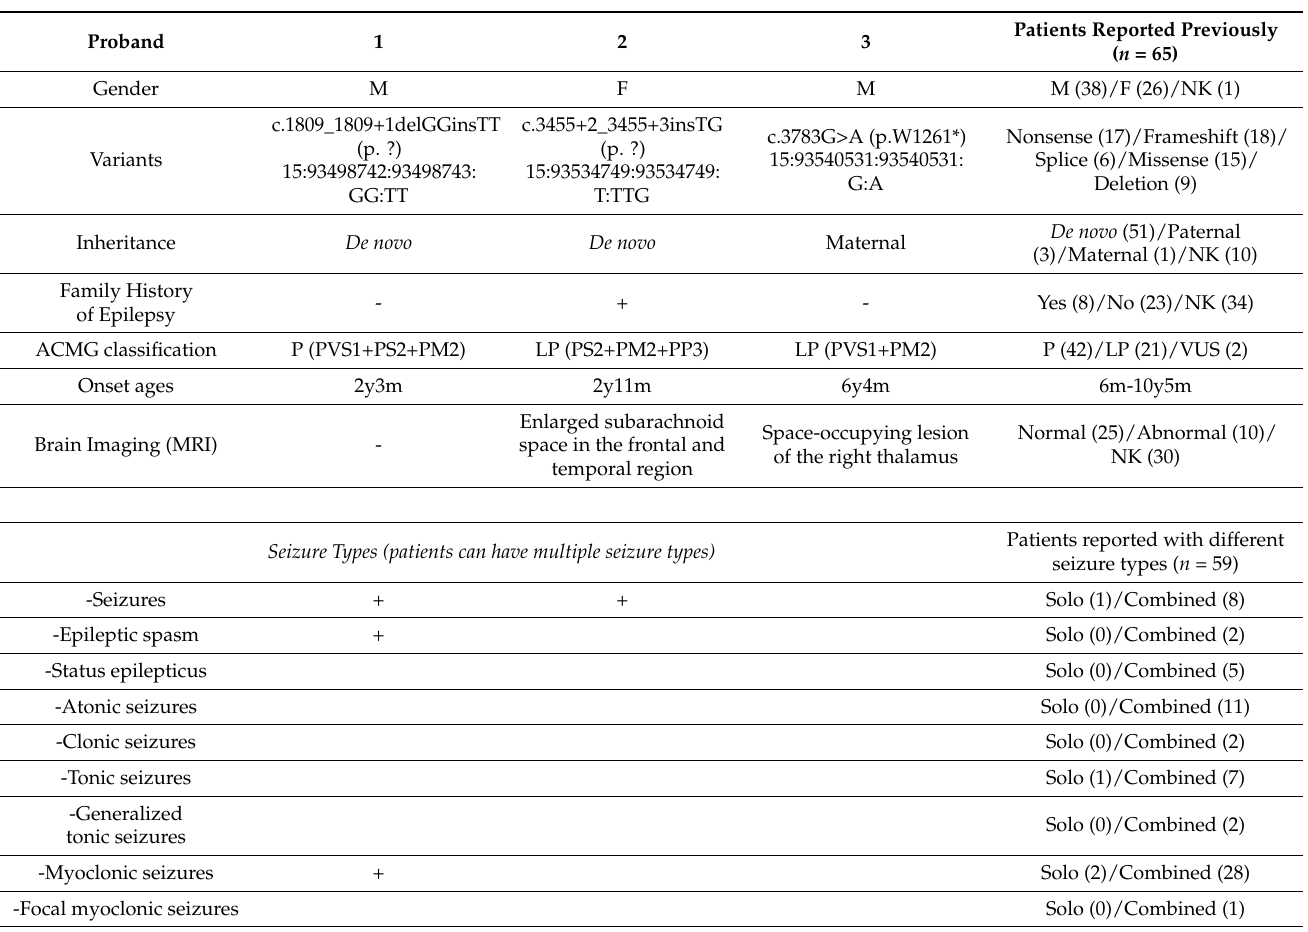
Table 1. Clinical and genetic characteristics of patients with CHD2